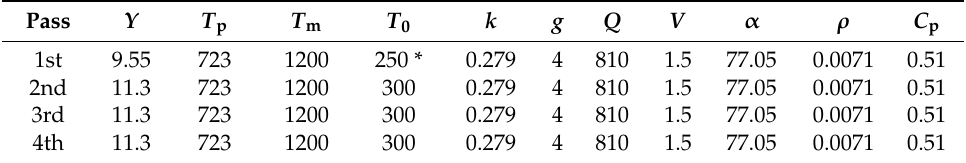
Table 7. HAZ width at peak temperature of 723 ◦